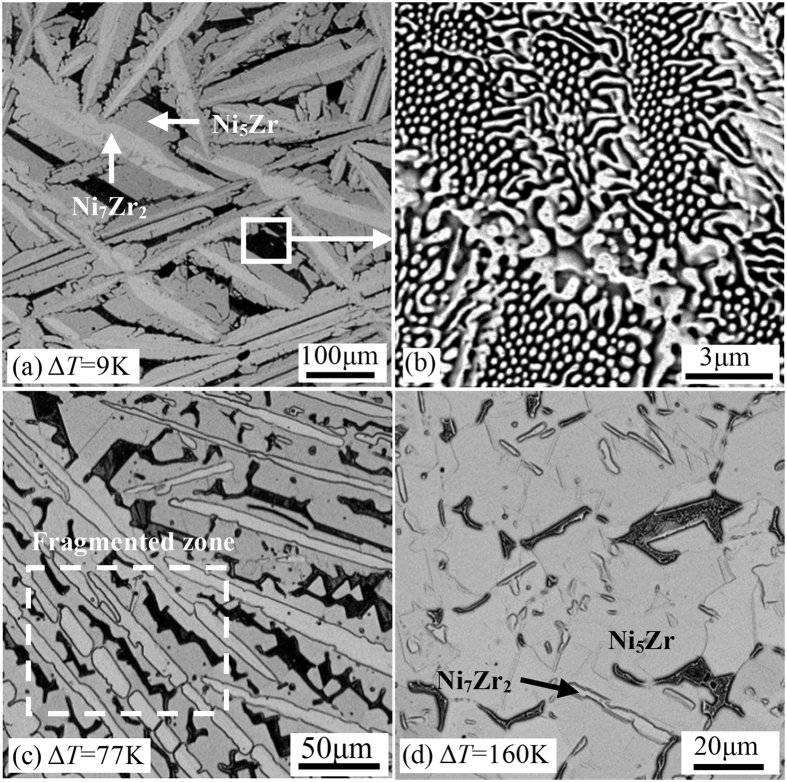
Solidified microstructures of undercooled Ni83.25Zr16.75 peritectic alloy at undercooling of (a,b) ΔT = 9 K, (c) ΔT = 77 K, and (d) ΔT = 160 K.